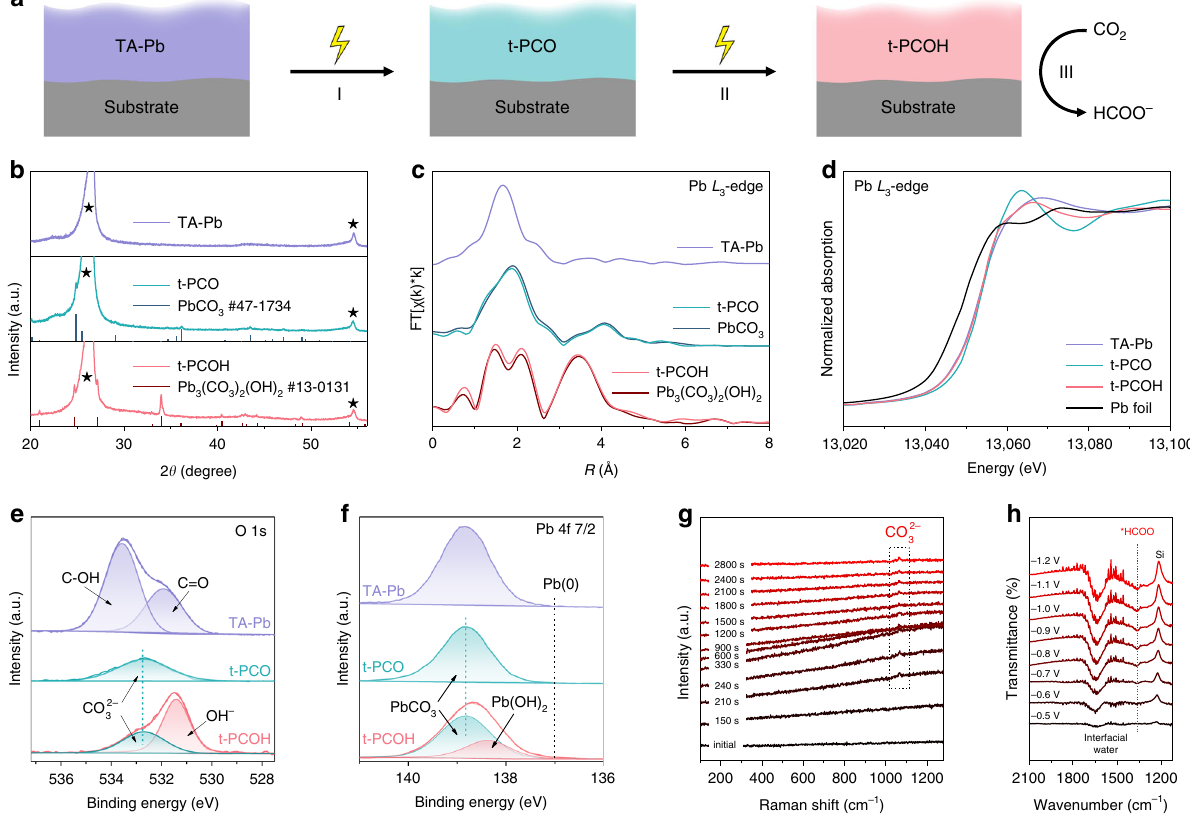
Fig. 2 Transformation of TA-Pb under cathodic potential. a Illustration of the transformation from TA-Pb to t-PCO and t-PCOH. b XRD patterns, c Quasi- in-situ Pb L 3 -edge EXAFS, d XANES spectra, e O 1s, and f Pb 4f 7/2 XPS spectra of TA – Pb, t-PCO and t-PCOH. The XRD peaks from the substrate are labelled by black stars. g Time-dependent in situ Raman spectra of TA – Pb under CO 2 bubbling. h Potential-dependent in situ ATR-FTIR spectra of hydrocerussite with CO 2 bubbling. The bands around 1640 and 1220 cm − 1 are attributed to the adsorbed interfacial water and the vibration of Si – O from silicon as the re fl ection window, respectively 51